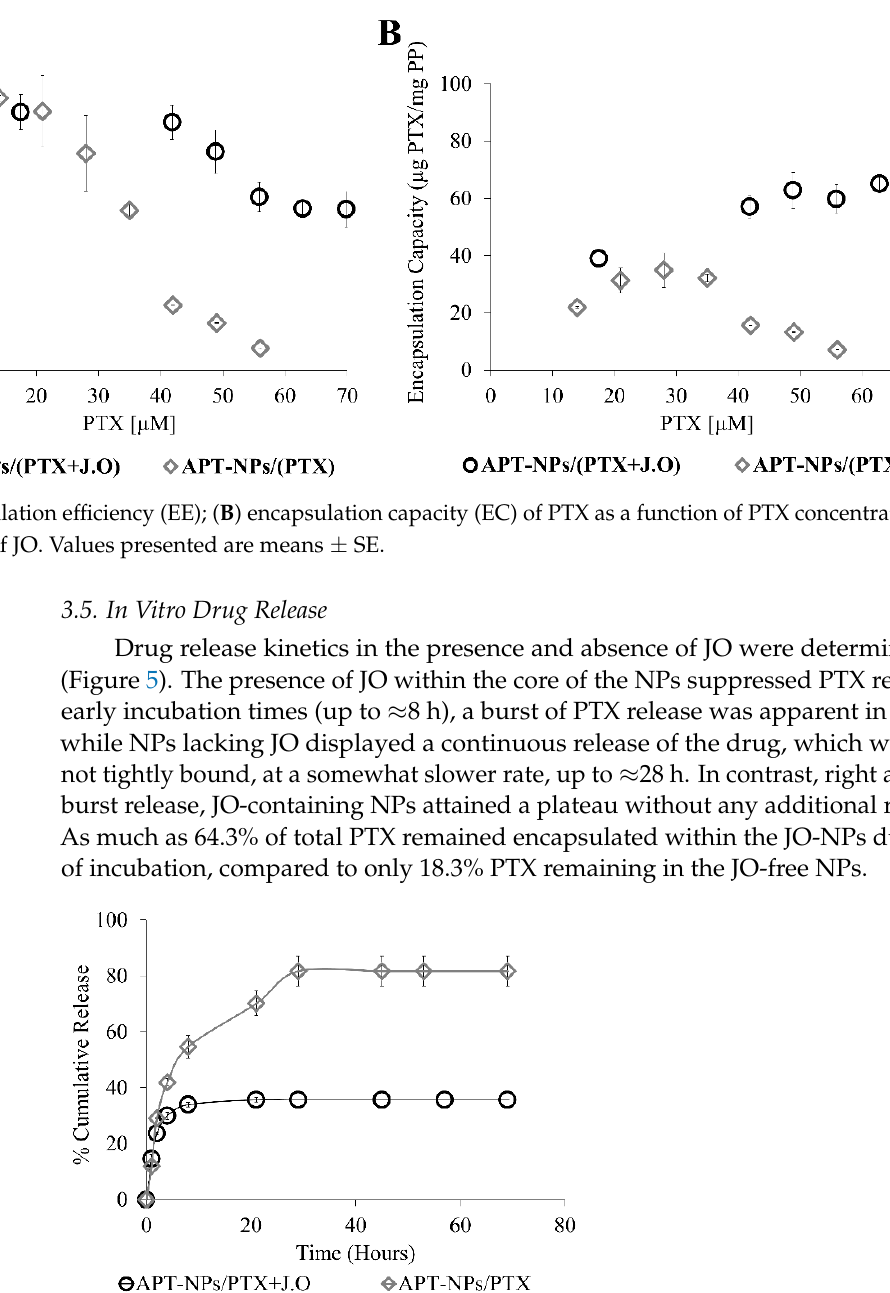
Figure 3. Cryo-TEM images of ( A ) APT-PP-NPs encapsulating 14 µM PTX; ( B ) APT-PP-NPs encapsulating 14 µM PTX + 88 µM JO; ( C ) APT-NPs encapsulating 14 µM PTX + 176 µM JO.